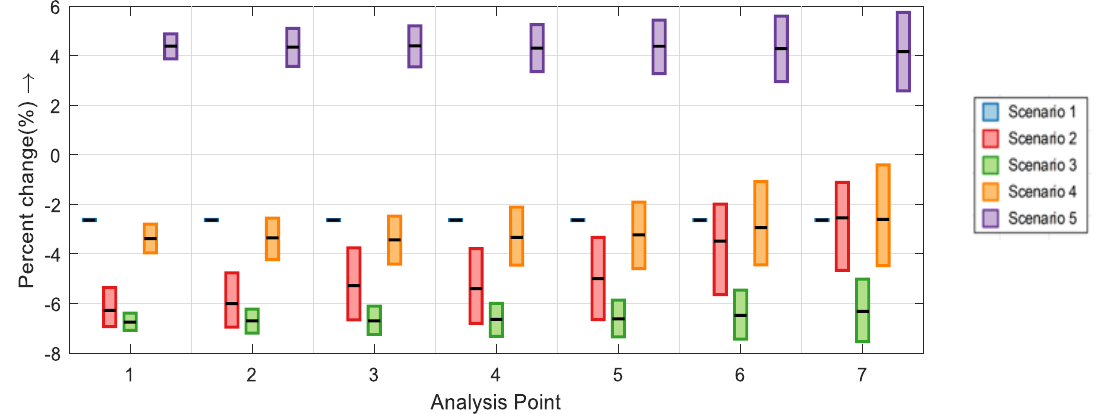
Figure 8. Relative difference between the neutral current RMS values under flat-top and sinusoidal supply voltage.